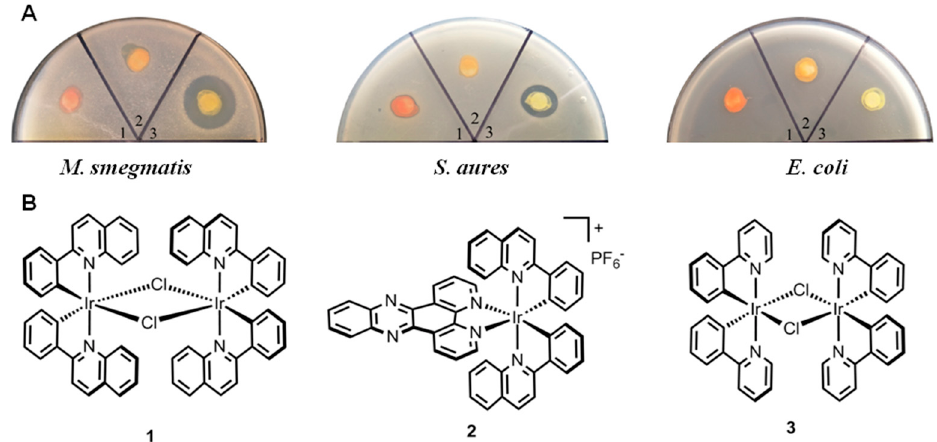
Figure 1. Anti-bacterial activity of complexes 1 – 3 as determined by the disk diffusion assay. ( A ) Strains including S. aureus ATCC 33591(MRSA), E. coli ATCC25922 and M. smegmatis mc 2 155; ( B ) Chemical structures of iridium complex 1 – 3 .